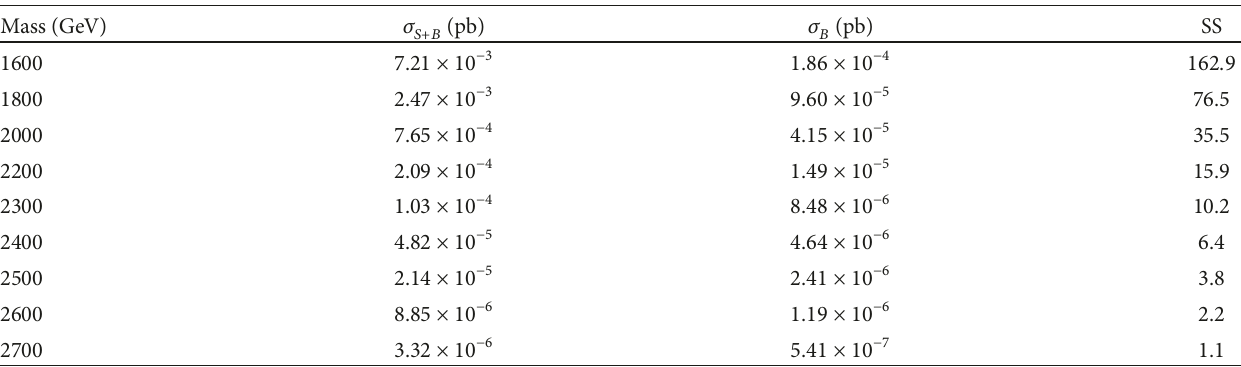
Table 2: The statistical significance (SS) values and the cross sections of the excited neutrino signal and relevant backgrounds at ERL 60⊗ FCC collider with √𝑠 = 3.46 TeV and 𝐿 int = 100 fb −1 , assuming Λ = 𝑚 ] ⋆ and 𝑓 = 𝑓 󸀠 = 1 . Mass